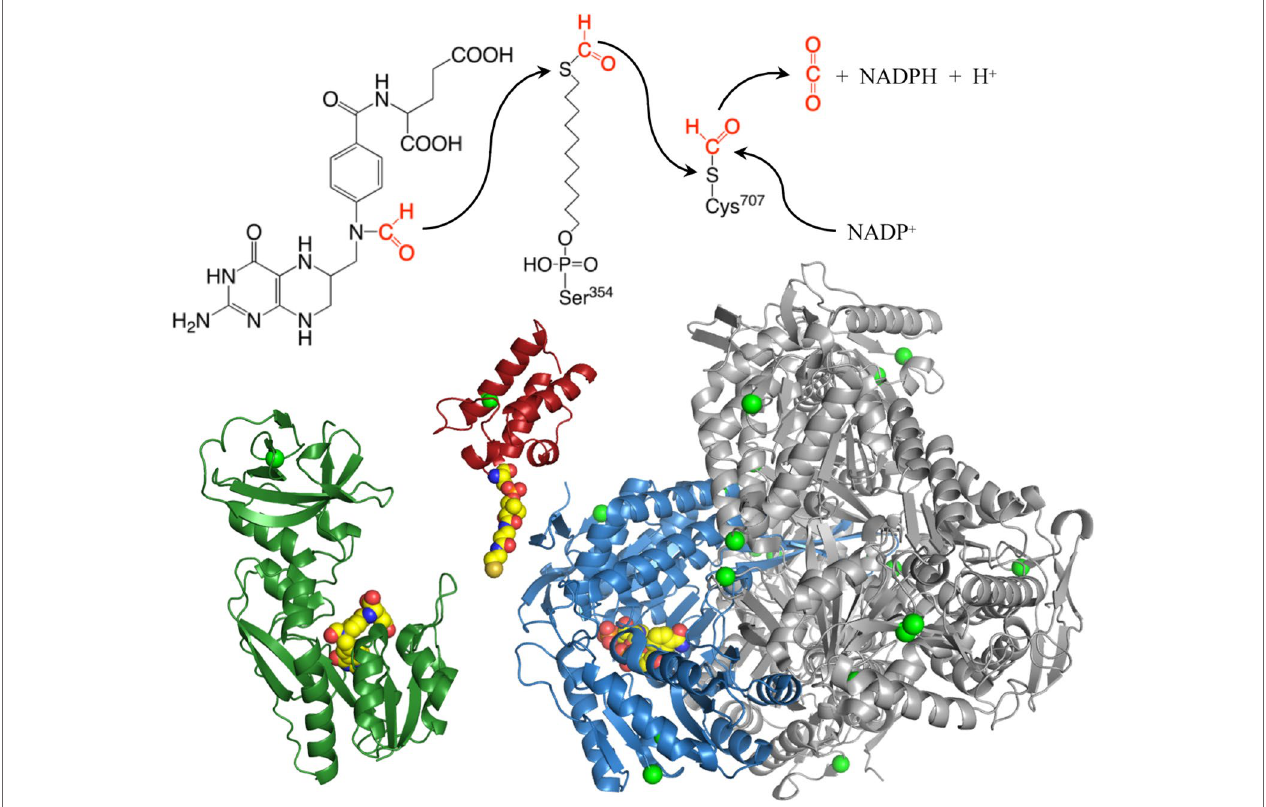
FiGURe 3 | Structures of the N-terminal formyltransferase ( dark green ), central acyl-carrier ( red , with manually added phosphopantetheinyl moiety), and C-terminal dehydrogenase ( blue and gray ) domains of ALDH1L1. Green spheres highlight positions of amino acids corresponding to exonic SNPs discussed in the text, other colored spheres show positions of 10-formyltetrahydrofolate (N-terminal domain), phosphopantetheine (intermediate domain), and NADP + (C-terminal domain). Subunit A of the tetrameric dehydrogenase domain is blue , subunits B, C, and D are gray . The extended phosphopantetheine is critical to the reaction as both the formyl donor (10-formyltetrahydrofolate) and electron acceptor (NADP + ) are located at the bottoms of clefts in the protein surface. PDB structures are: 4tt8 (N-terminal domain); 2cq8 (intermediate domain); and 2o2q (aldehyde dehydrogenase